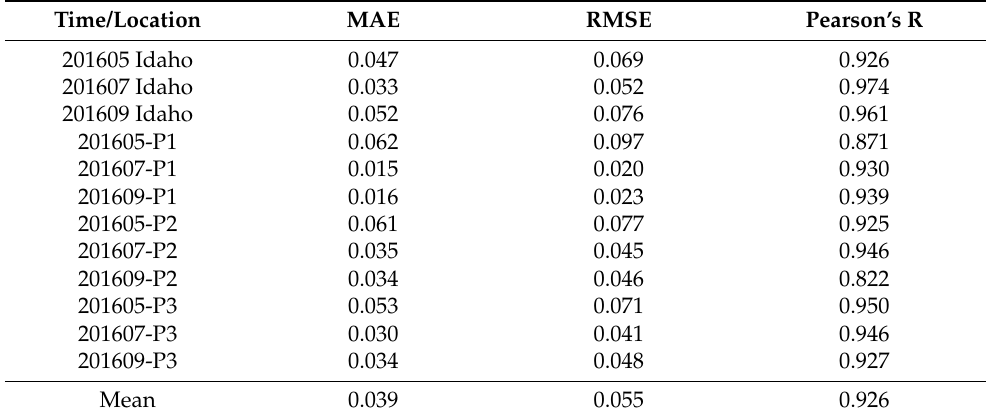
Table 1. Error statistics for the comparison between downscaled NDVI and MODIS NDVI of Idaho. Time/Location MAE RMSE Pearson’s